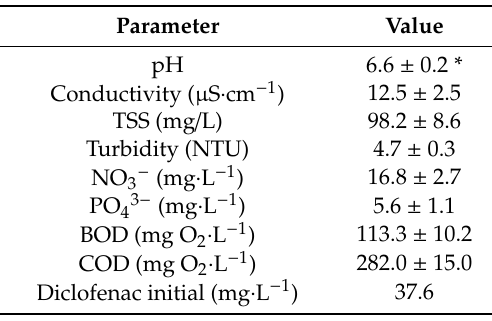
Table 1. Initial composition of working solution. COD, chemical oxygen demand.